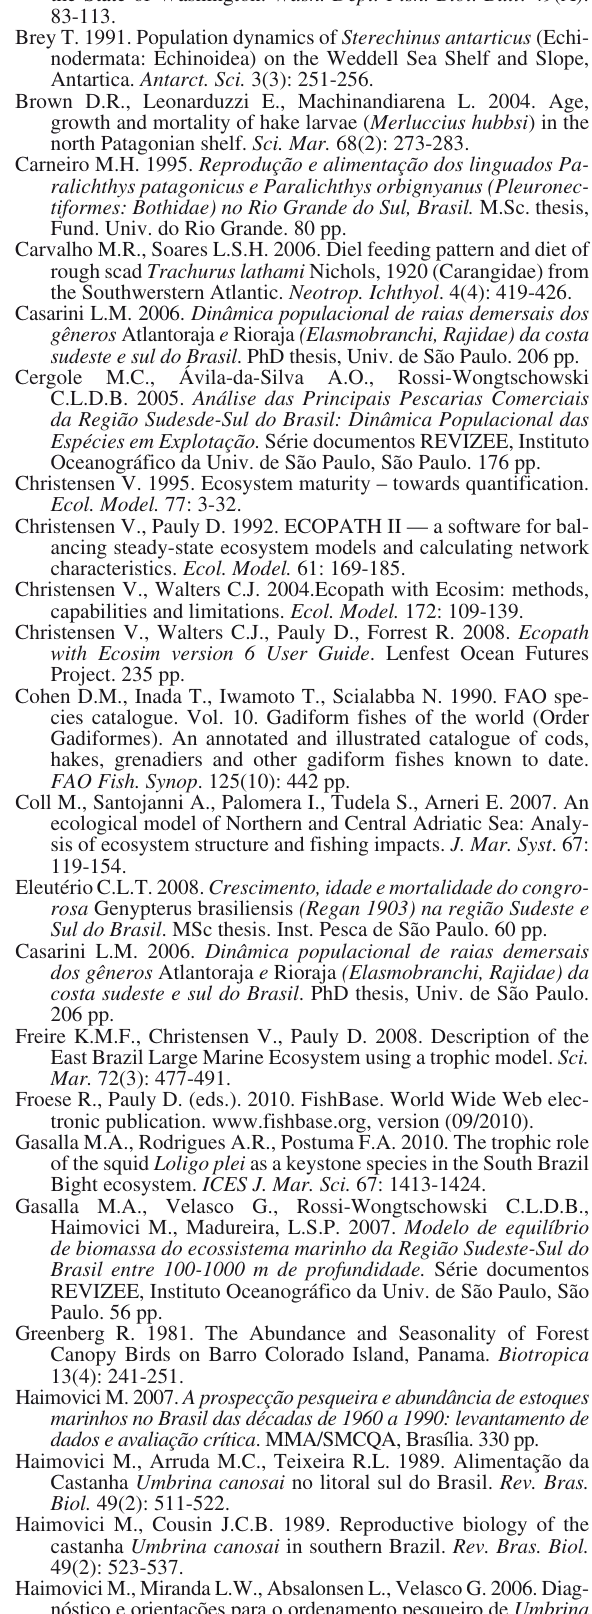
Picard C. 2008. Difference in diet and size-related trophic level in two sympatric fish species, the red mullets Mullus barbatus and Mullus surmuletus , in the Gulf of Lions (north-west Medi- terranean Sea). J. Fish Biol. 73(10): 2402-2420. Bezzi S., Cañete G., Pérez M., Renzi M., Lassen H. 1994. Report of the INIDEP Working group on assessment of Hake (